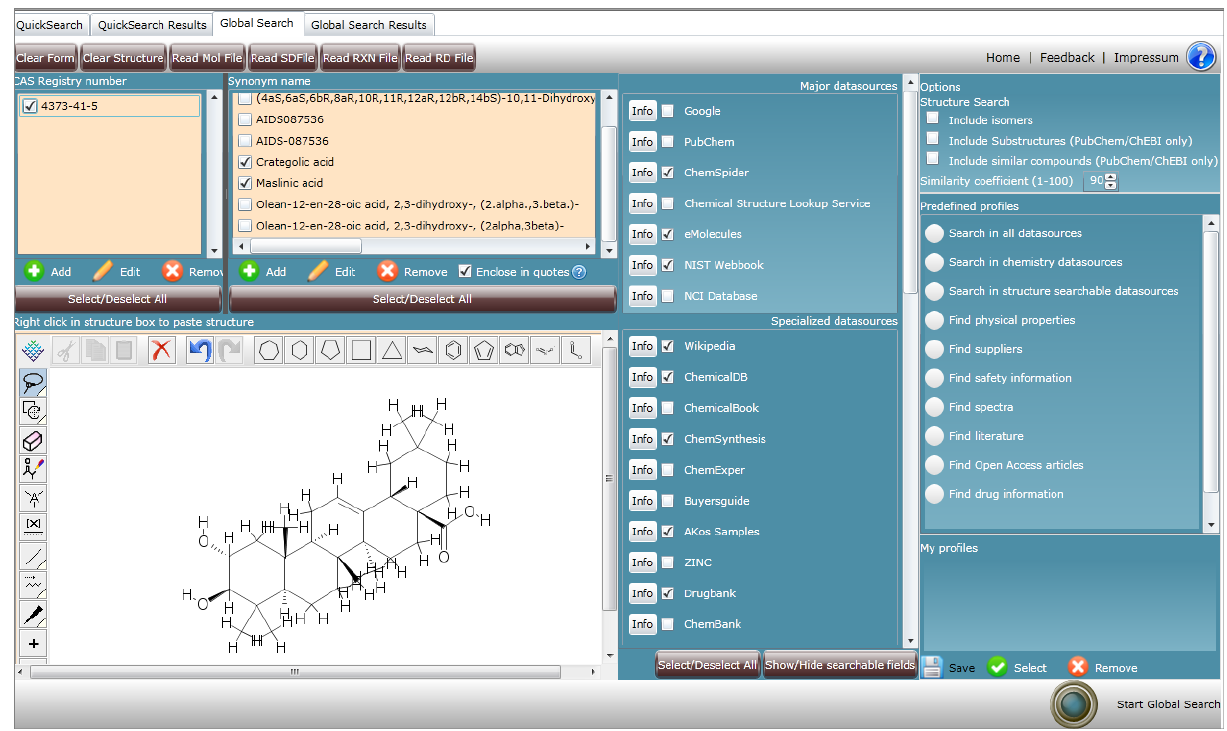
Figure 2. The CWM Global Search user interface Global Search — Combined CAS registry number synonym, and structure search for maslinic